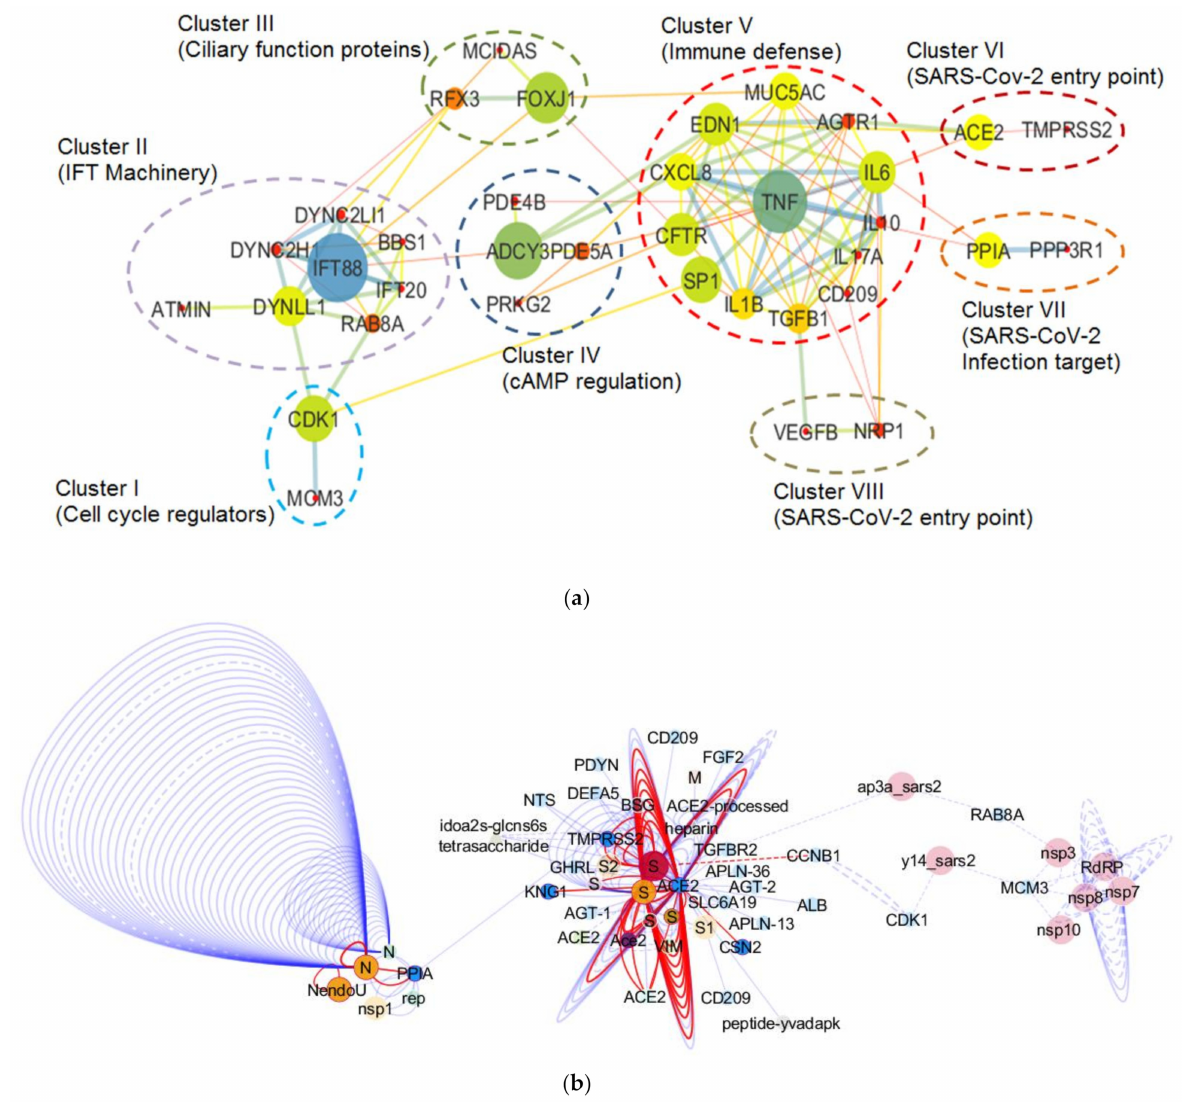
Figure 4. Severe acute respiratory syndrome coronavirus-2 (SARS-CoV-2)-induced changes in the molecular machinery regulating mucociliary clearance. ( a ) Interactome representing the SARS-CoV-2 infection-induced implications in the molecular machinery regulating mucociliary clearance. The principal nodes and paths driving the molecular network were analyzed using Cytoscape 3.7.2. The network analysis was performed using the betweenness centrality algorithm, where the sizes of the nodes (circles) indicate betweenness. The color scale ranges from blue–green–yellow to orange, representing low to high betweenness values, respectively. Clustering analysis was performed by employing the MCL algorithm. Perforated shapes represent different clusters (I–VIII). Clusters I–V consist of proteins involved in cell cycle regulation, IFT machinery, cilia biogenesis and regulation, cAMP regulation, and immune defense, respectively. Clusters VI–VIII represent proteins acting as SARS-CoV-2 entry point and infection targets, respectively. CDK1 (cluster I), minichromosome maintenance 3 (MCM3; cluster I), RAB8A (cluster II), CD209 (cluster V), angiotensin converting enzyme (ACE2; cluster VI), PPIA (cluster VII), and neuropilin-1 (NRP1; cluster VIII) proteins are known to interact with viral proteins during the course of infection. ( b ) Partial interactome of SARS-CoV-2 and host proteins extracted from Network Data Exchange (NDEx) public server (www.ndexbio.org) representing the IntAct/IMEx Coronavirus Dataset. The protein–protein interaction networks (PPIs) were visualized in Cytoscape 3.7.2 (with CyNDEx-2 application) with the Compound Spring Embedder (CoSE) layout. Each edge represents interaction studied in different experiments. Edge highlighted in red represents evidence from mutation study. Dashed lines represent spoke-expanded interactions. Node color shows different species origin, where pink and orange colors represent SARS-CoV-2 origin and the blue color is used to denote human origin